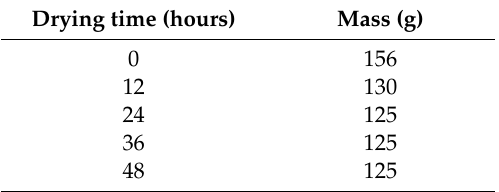
Table 1. Mass change of waste co ff ee grounds (WCG) with drying time.